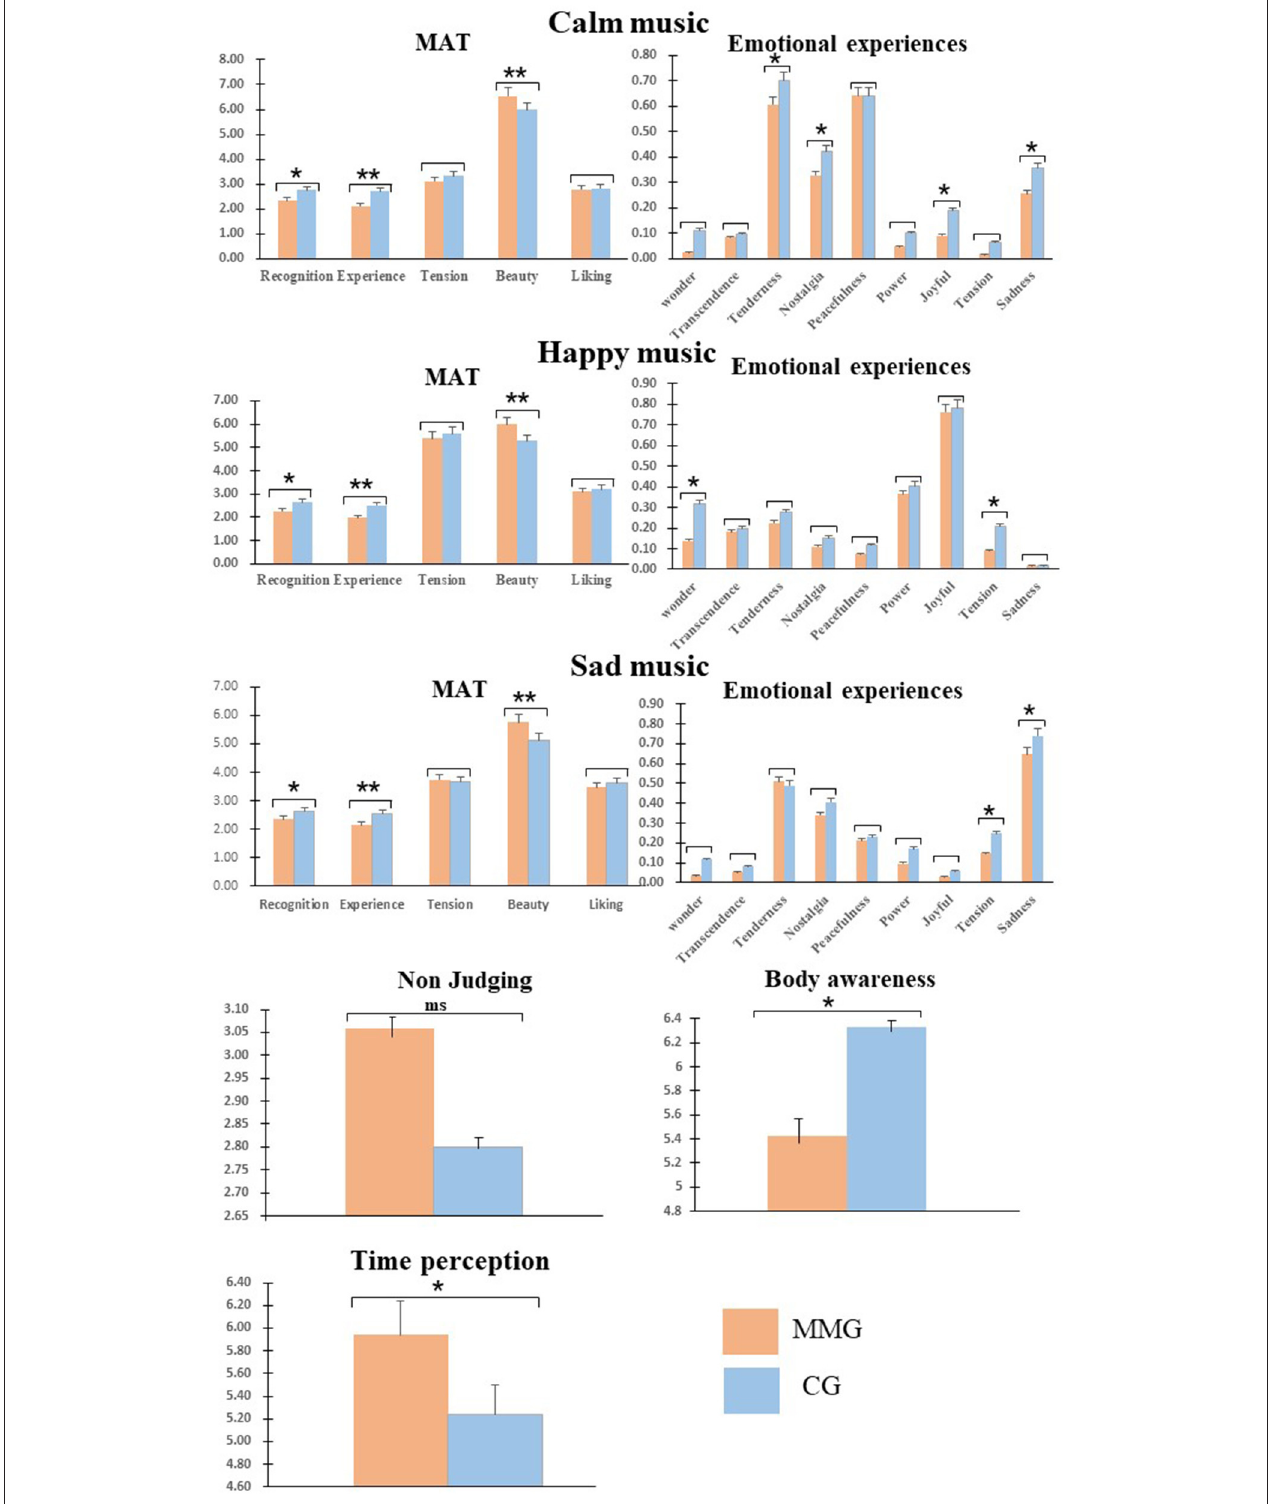
FIGURE 2 | Differences between MMG and CG in the musical aesthetic tasks of music with three emotional levels, non-judging, body awareness, and time perception. MMG, mindfulness meditation group; CG, control group; MAT, Music Aesthetics Task; ms, significant marginally difference; * p < 0.05, ** p < 0.01.